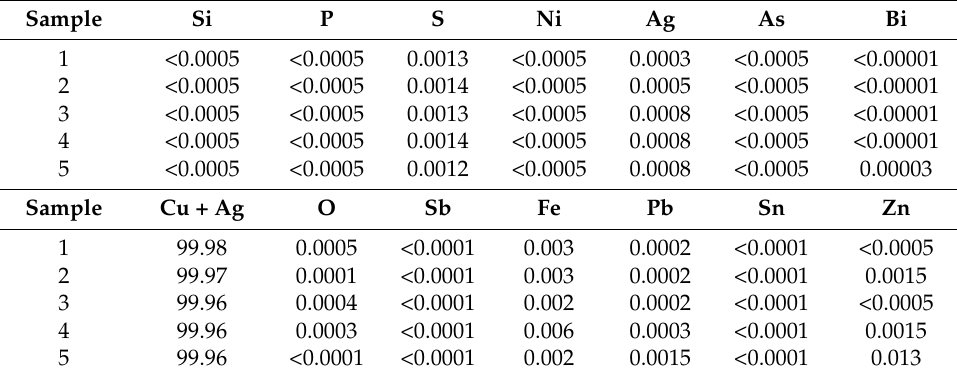
Table 2. Chemical composition of test samples (wt. %).